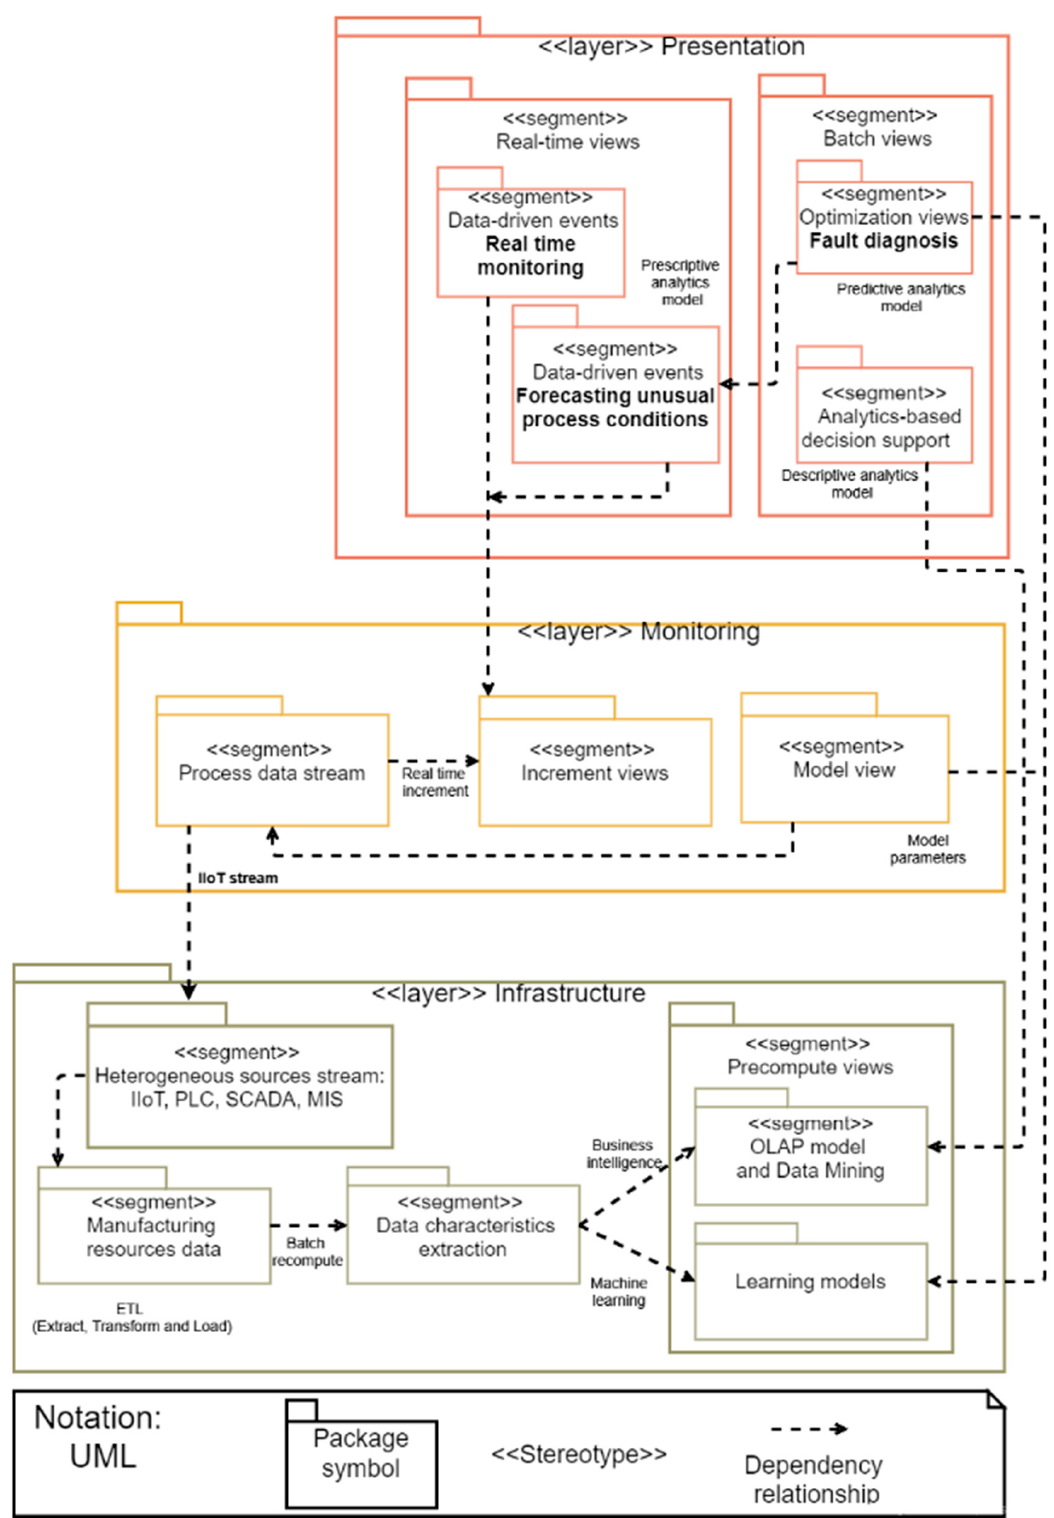
Figure 8. Layered data management architecture for iCPS Big Data analytics in Industry 4.0.